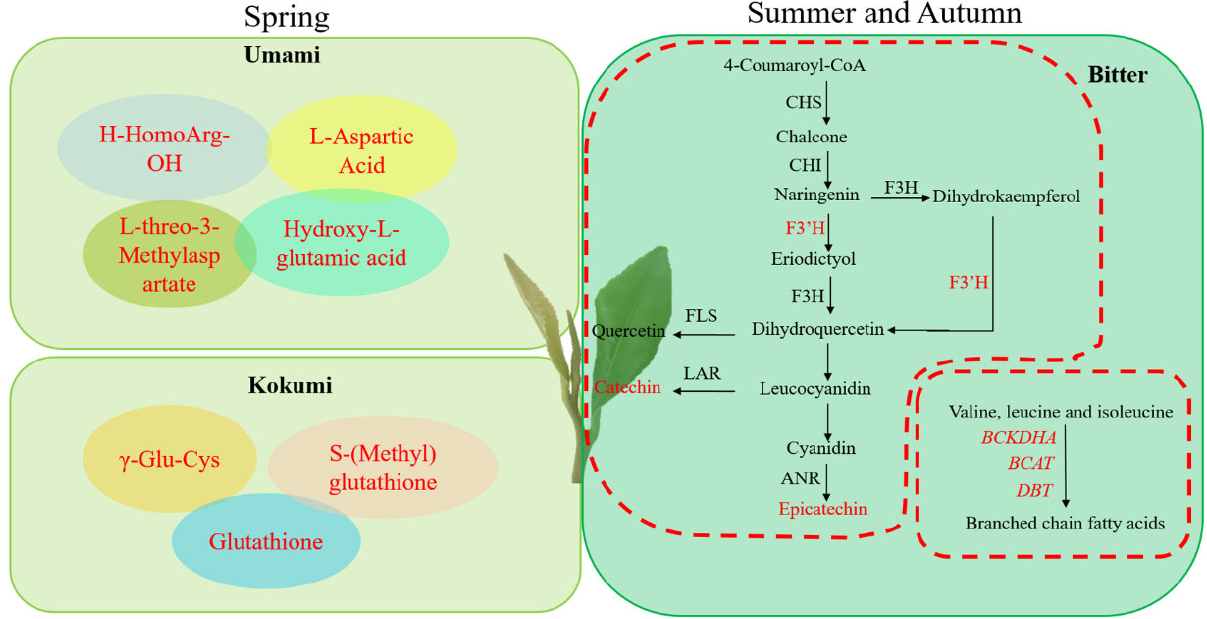
Figure 5. The potential mechanism of flavor changes of Changqing tea during different seasons. Red letters represent up-regulated DEGs or metabolites.